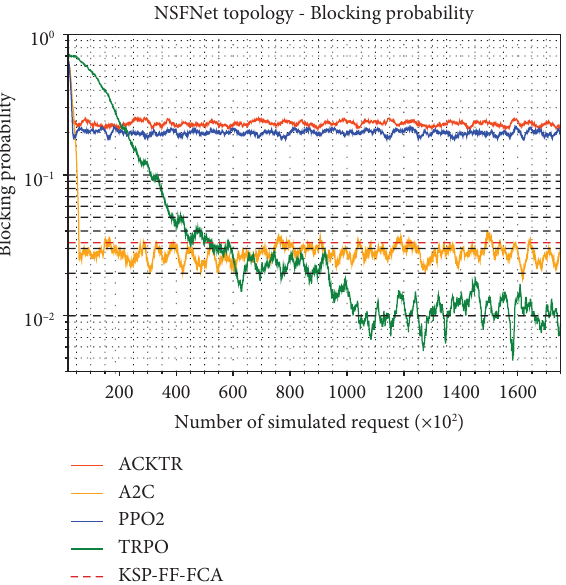
Figure 3: Accumulated reward for the A2C, PPO2, TRPO, and ACKTR agents in the NSFNet topology.